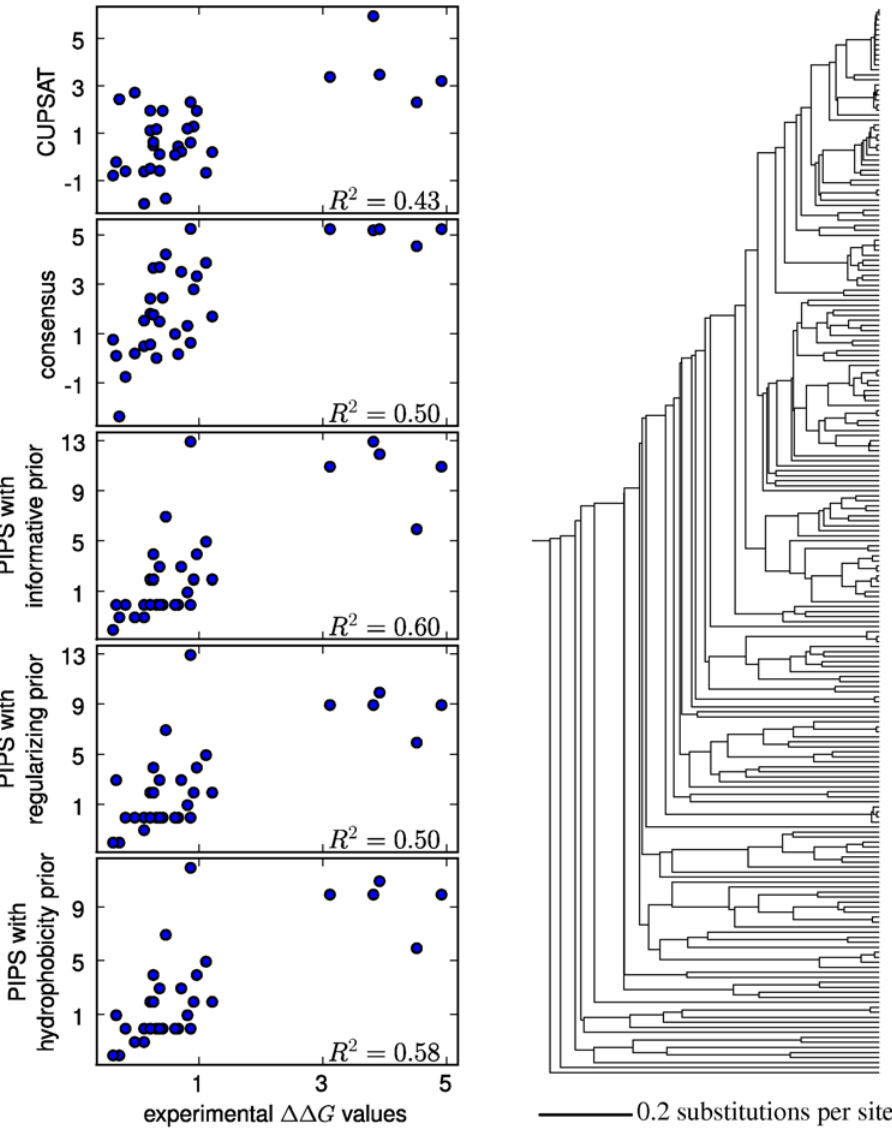
Figure 7. Experimentally measured and predicted DD G values for the 109-residue thioredoxin protein. The plots at left show the predictions made by the CUPSAT physicochemical modeling program, the consensus approach, and the PIPS phylogenetic inference program using the informative, regularizing, and hydrophobicity. To the right is the phylogenetic tree of 213 sequences that was utilized by the PIPS program. The R 2 values are the squared Pearson correlation